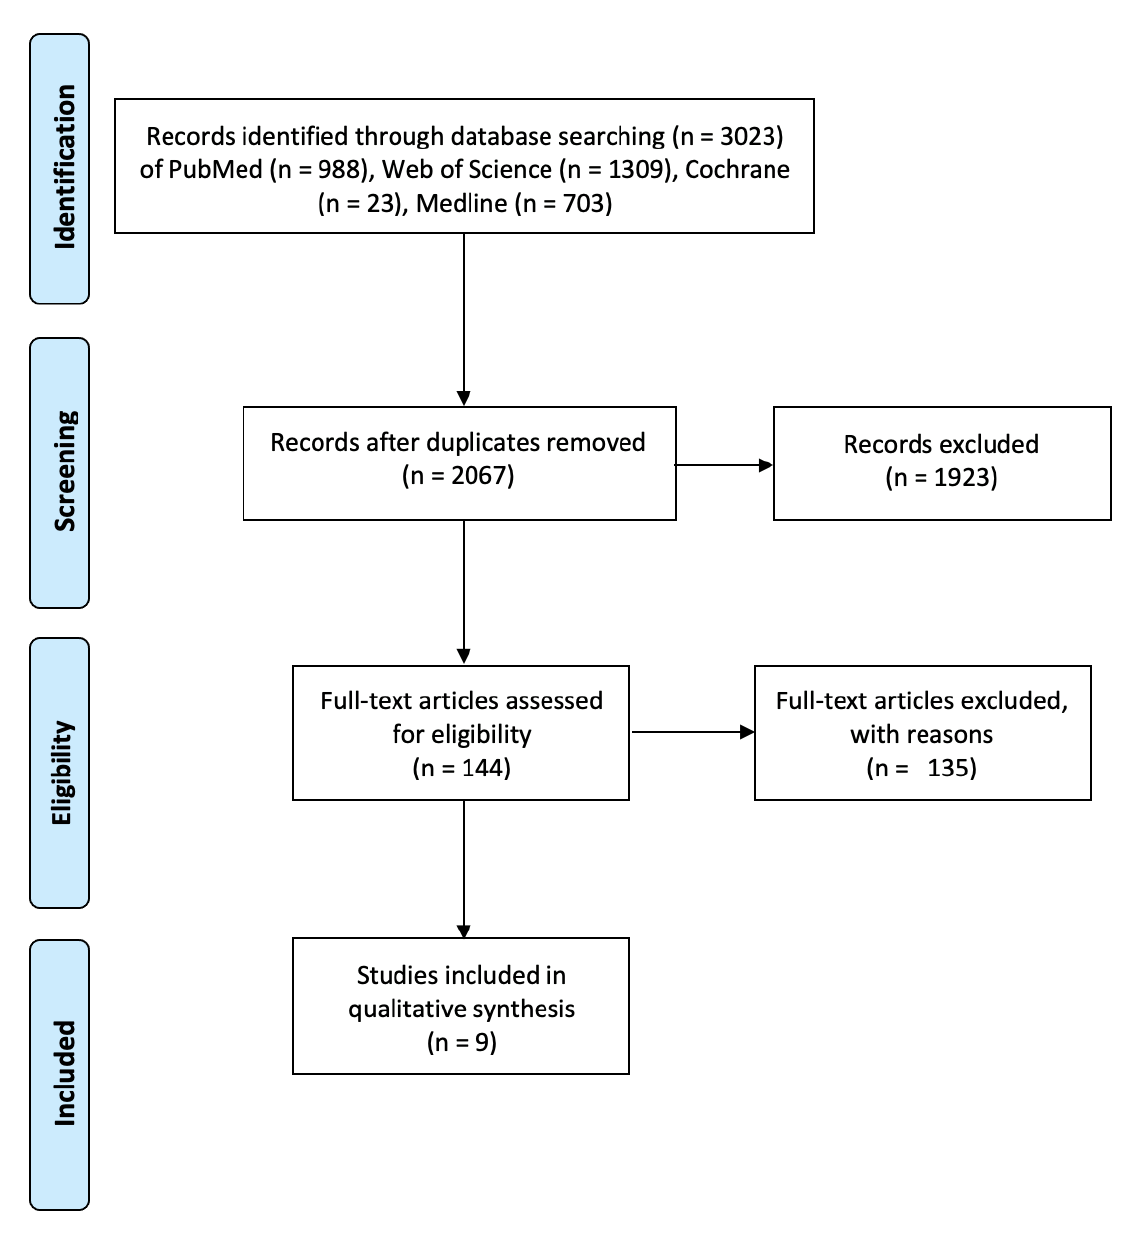
Figure 2. Overview of the identification, screening, and eligibility of studies, using the PRISMA Flow Diagram [53] .